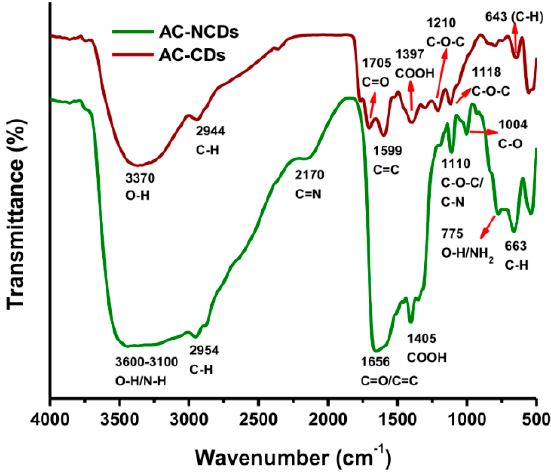
Figure 4. FTIR spectra of AC-CDs and AC-NCDs.